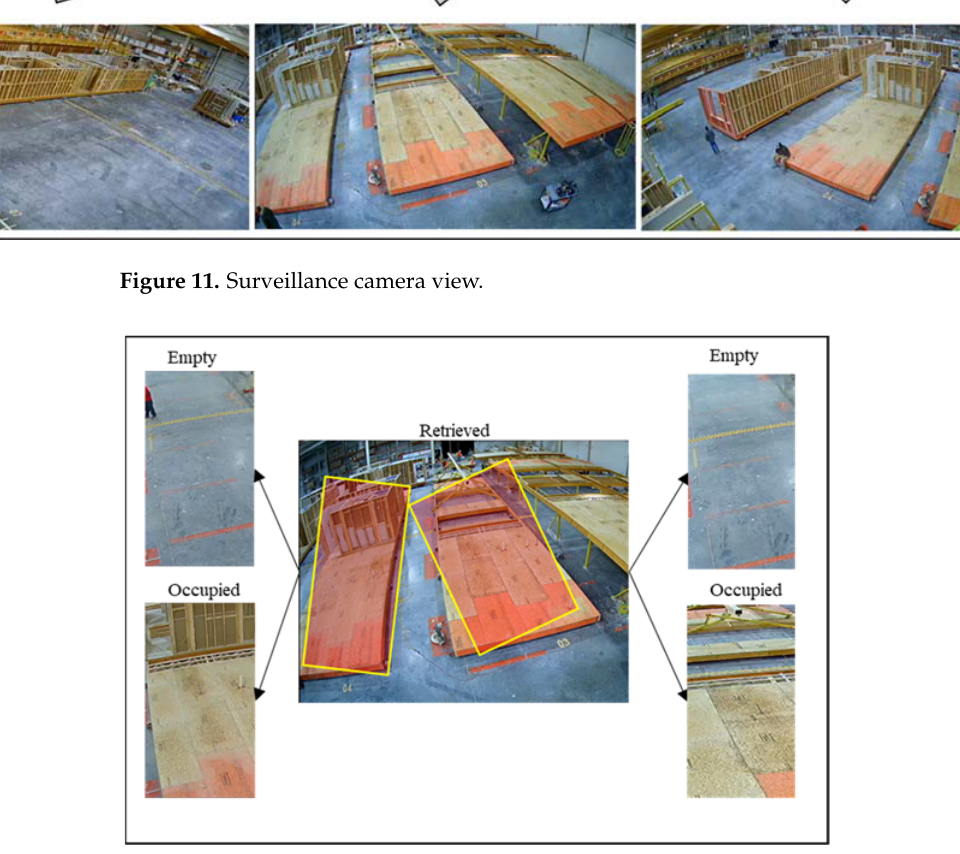
Figure 13. SIFT output where red circles indicate the SIFT keypoints.